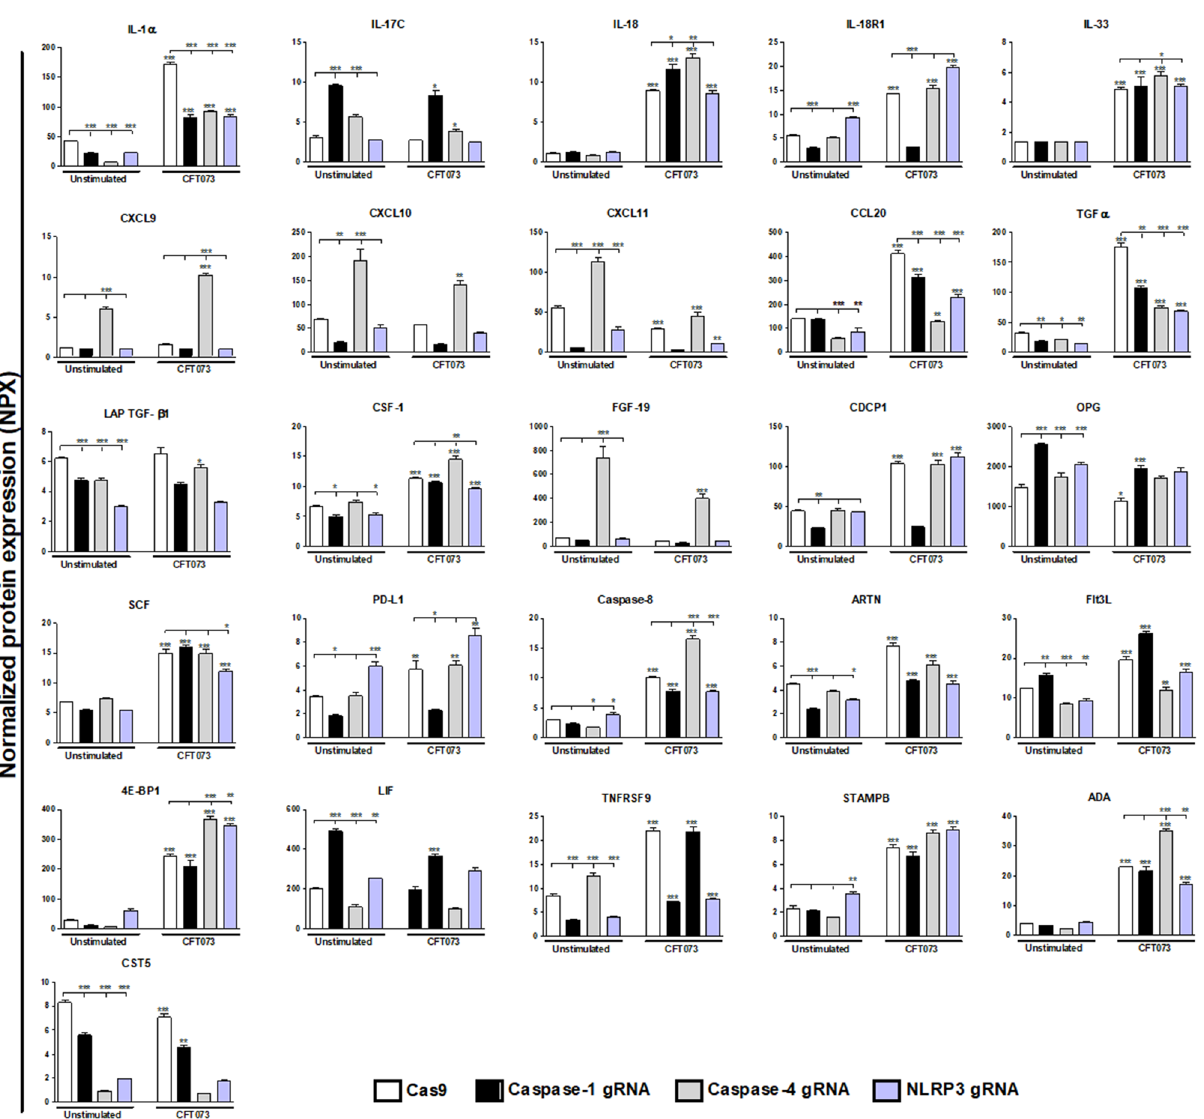
Figure 5. Targeted protein analysis of basal and UPEC-induced protein expression from bladder epithelial cells knockdown in caspase-1, caspase-4 or NLPR3. Caspase-1, caspase-4 and NLRP3-knockdown bladder epithelial cells and Cas9 controls were infected with CFT073 followed by analysis of protein expression using a panel of inflammation-related proteins. All proteins that responded to stimulation with the UPEC strain CFT073 with either a significant increase or decrease in protein expression are presented. The protein data is presented as normalized protein expression (NPX). gRNA stands for guideRNA targeting specific gene using CRISPR/Cas9. Data are presented as mean ± SEM of three independent experiments. Asterisks over error-bar show statistical significance compared to respective unstimulated control (* p < 0.05, ** p < 0.01, *** p <